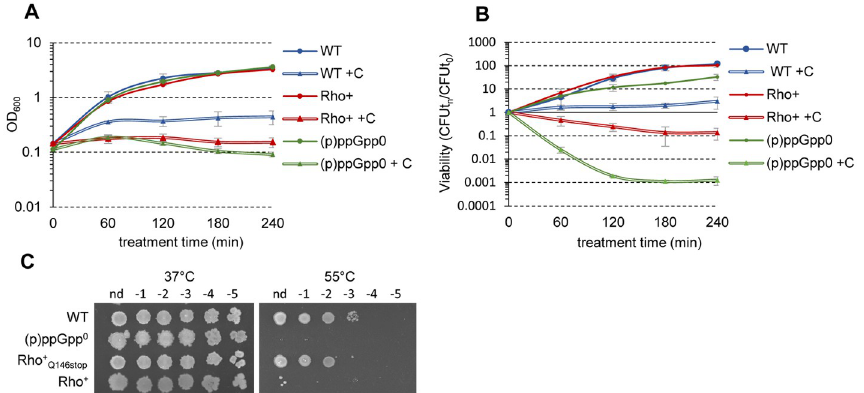
Fig 9. Sensitivity of B . subtilis Rho + to fatty acid starvation and heat stress. Growth curves ( A ) and viability ( B ) of B . subtilis WT (blue lines), its isogenic (p)ppGpp 0 (green lines) and Rho + (red lines) strains non-treated (solid lines; circles) or starved for fatty acids by treatment with cerulenin (+ C; double lines; triangles). Cells were grown in LB at 37˚C to OD 600 0.1, and cerulenin was added to the halves of cultures to final concentration 10 μ g/ml. Cell survival was estimated by plating bacterial cultures at the indicated time on LB agar and counting of CFUs after 18 h of incubation at 37˚C. Each data point in B is the mean of at least three counts. ( C ) Colony formation of B . subtilis WT and its isogenic (p)ppGpp 0 , Rho + and Rho + Q146Stop (Sup 1) strains at 37˚C and 55˚C. Cell cultures growing exponentially in LB medium at 37˚C were spotted in serial dilutions (from 0 to 10 − 5 ) on LB agar plates and incubated at 37˚C or at 55˚C for 18 h before imagining.